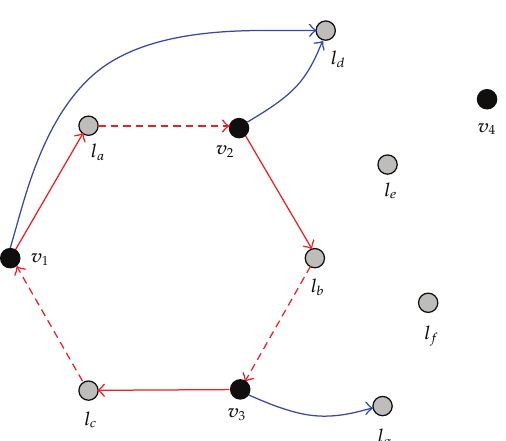
Figure 5: Example for a solution to (cid:2) 3.26 (cid:3) – (cid:2) 3.38 (cid:3) . The octagon-shaped cycle constitutes the odd hole. The dashed arcs do not contribute to the objective function, whereas the solid arcs (cid:2) which connect nodes to labels (cid:3) contribute with the LP-value of the target-label as coe ffi cient. The further arcs provide a lower bound for the contribution of all labels that need to be lifted in order to obtain a valid inequality for the initial